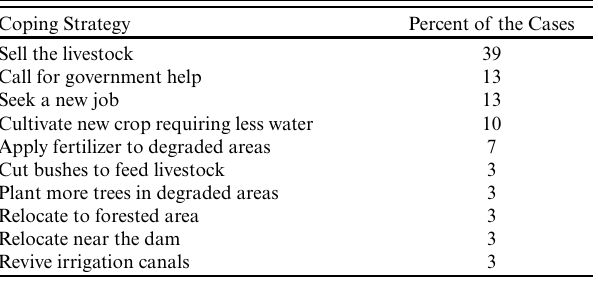
Table 3 . Coping strategies identified under extreme rainfall variability, grazing game